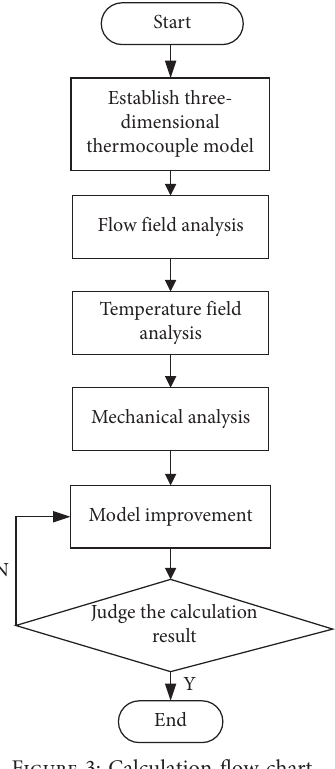
Figure 3: Calculation flow chart.